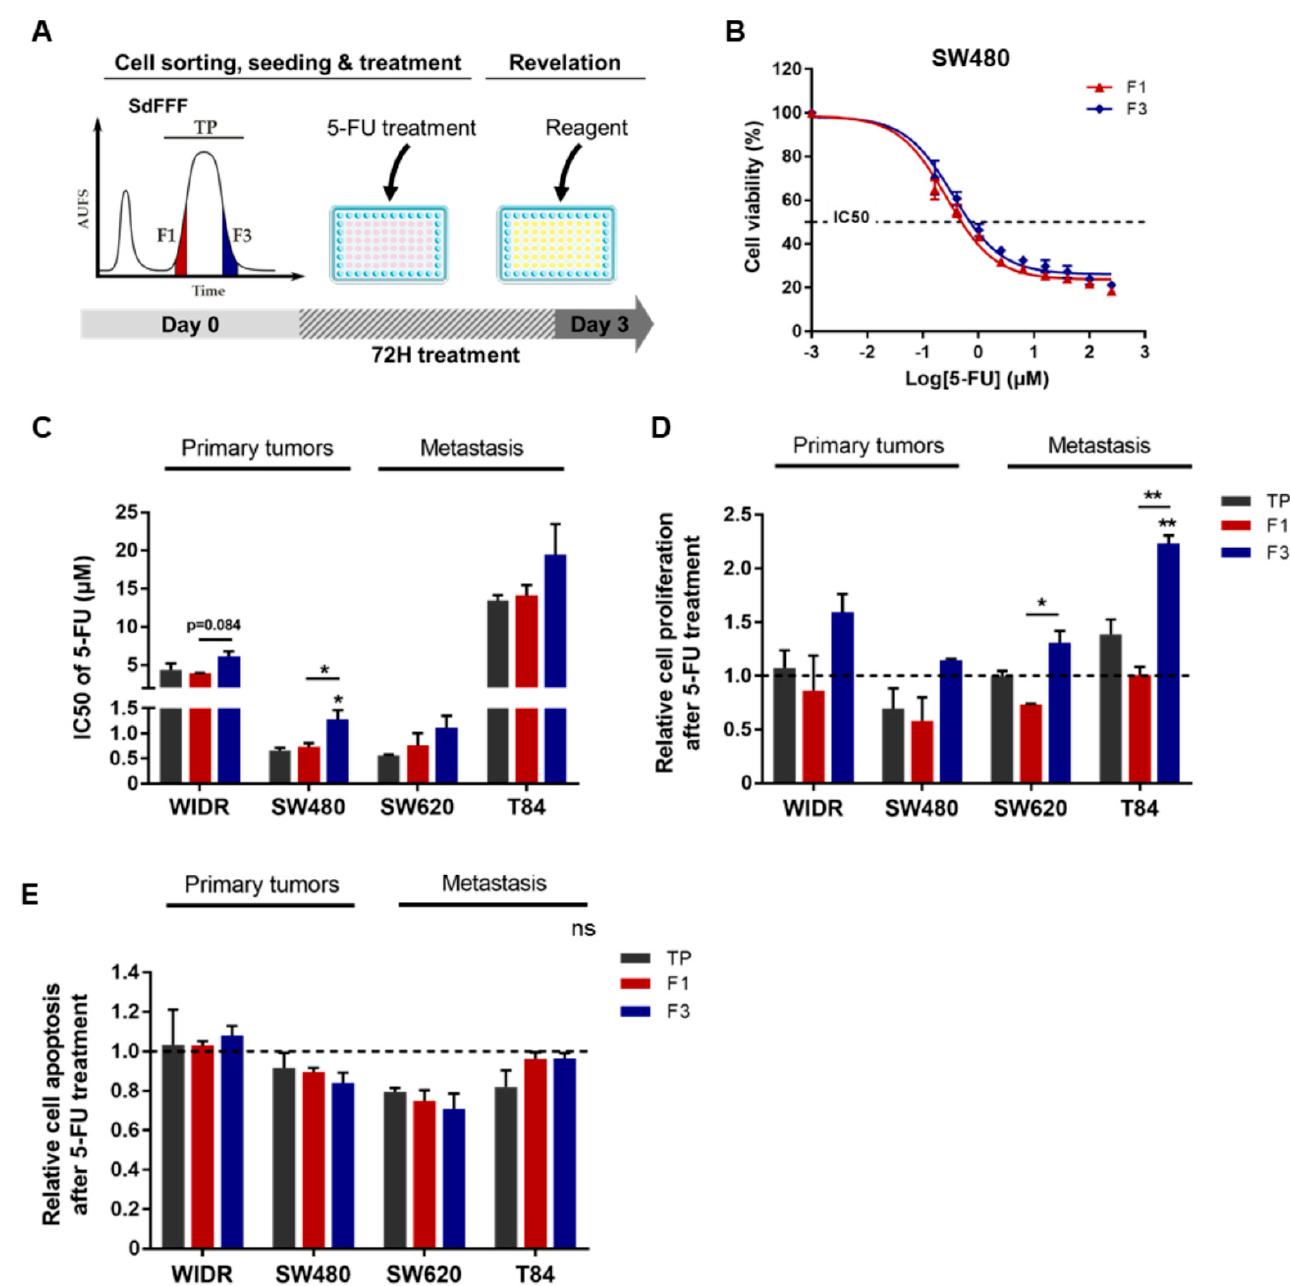
Figure 4. 5-FU resistance of F3 subpopulation from CRC cell lines. ( A ) Schematic representation of 5-FU response analysis performed. After cell sorting by SdFFF, cell subpopulations were treated with 5-FU for three days and then cell viability, proliferation, and apoptosis analyses were performed. ( B , C ) After 5-FU treatment, cell viability analyzed by MTT assay was presented as a dose–response curve for the SW480 cell line ( B ) and a bar plot with IC50 values obtained from all cell lines ( C ). ( D ) Cell proliferation rate after 5-FU treatment was measured by BrdU assay and presented in the bar plot as a ratio between treated and untreated conditions (dashed line). ( E ) After 5-FU treatment, apoptosis rate was measured using ELISA cell death assay and compared with the untreated condition (dashed line). All these results are represented as means ± SEM and statistical differences with ‘ns’ means a non-significant result both between the sorted cell subpopulations and between a sorted subpopulation and the control, * p -value < 0.05, ** p -value < 0.01, and * alone for significant results compared to TP using one ‐ way ANOVA test.